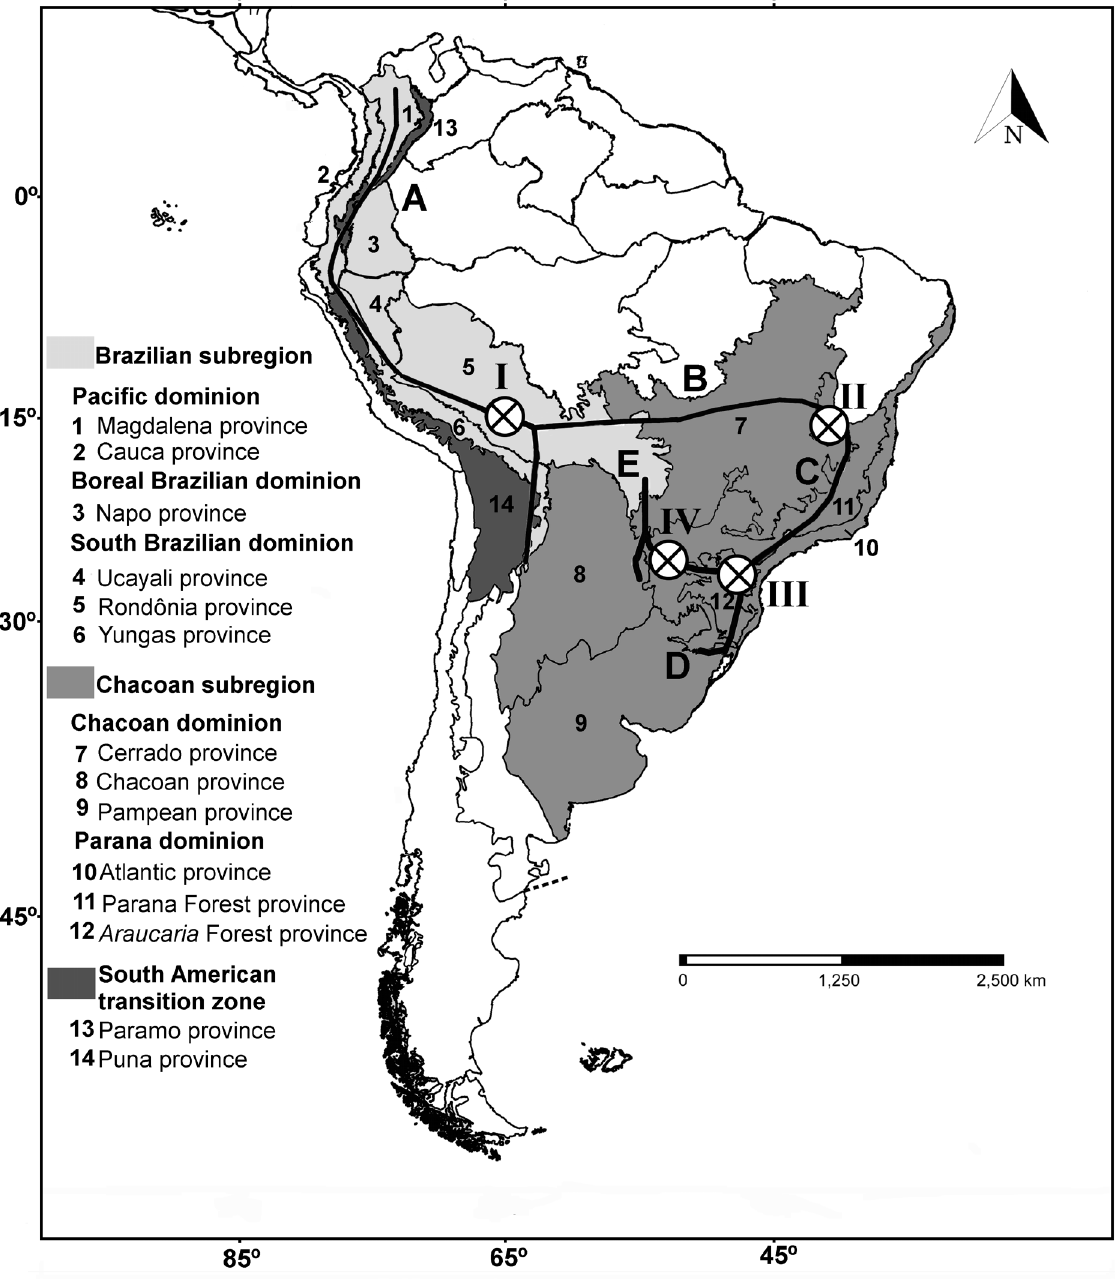
Figure 1 – Superposition of generalized tracks and nodes with the biogeographic provinces of the Neotropical region (modified from Morrone